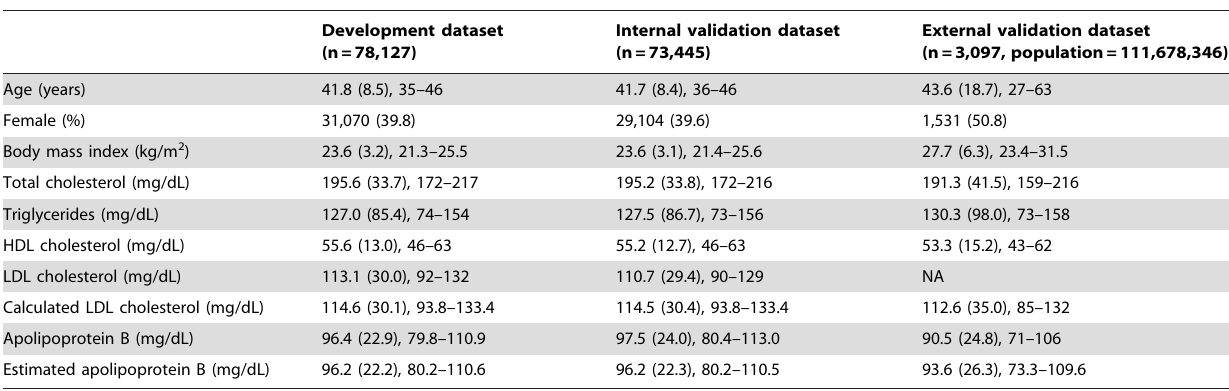
Table 1. Participants’ characteristics.